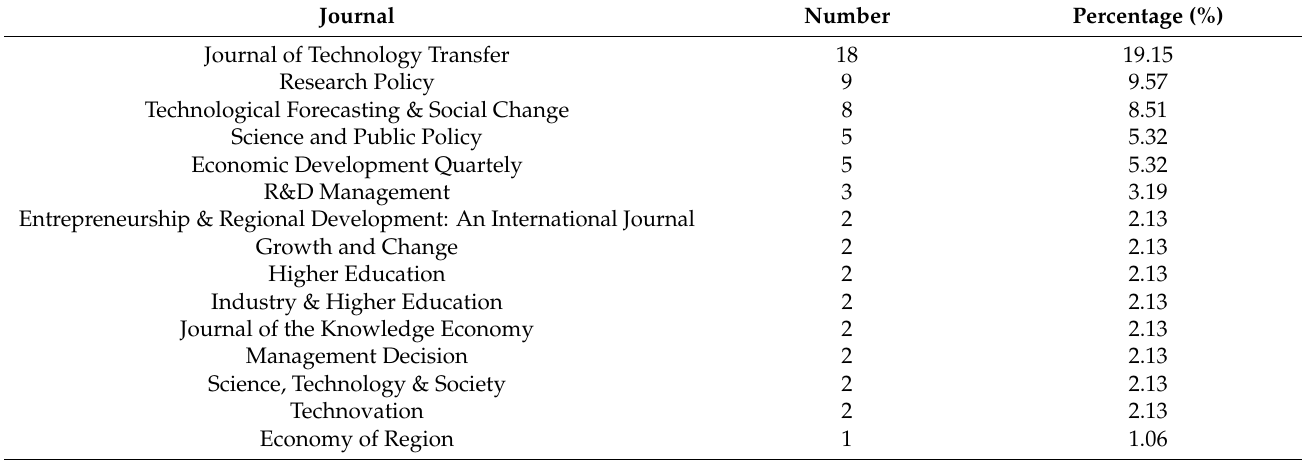
Table 2. Number and percentage of articles per